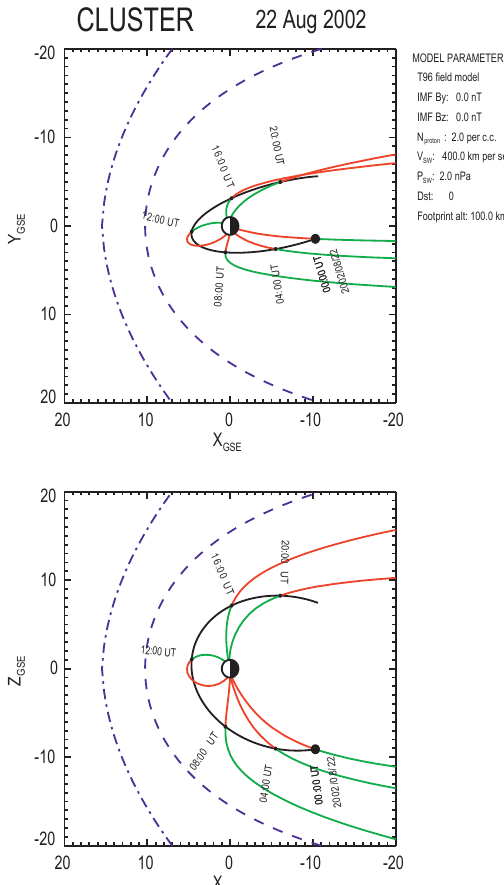
Fig. 1. The orbit of the cluster satellites on 22 August 2002 in GSE coordinates, indicating that during 10:00–12:00 UT the satellites cross the dipolar field lines in the inner magnetosphere.